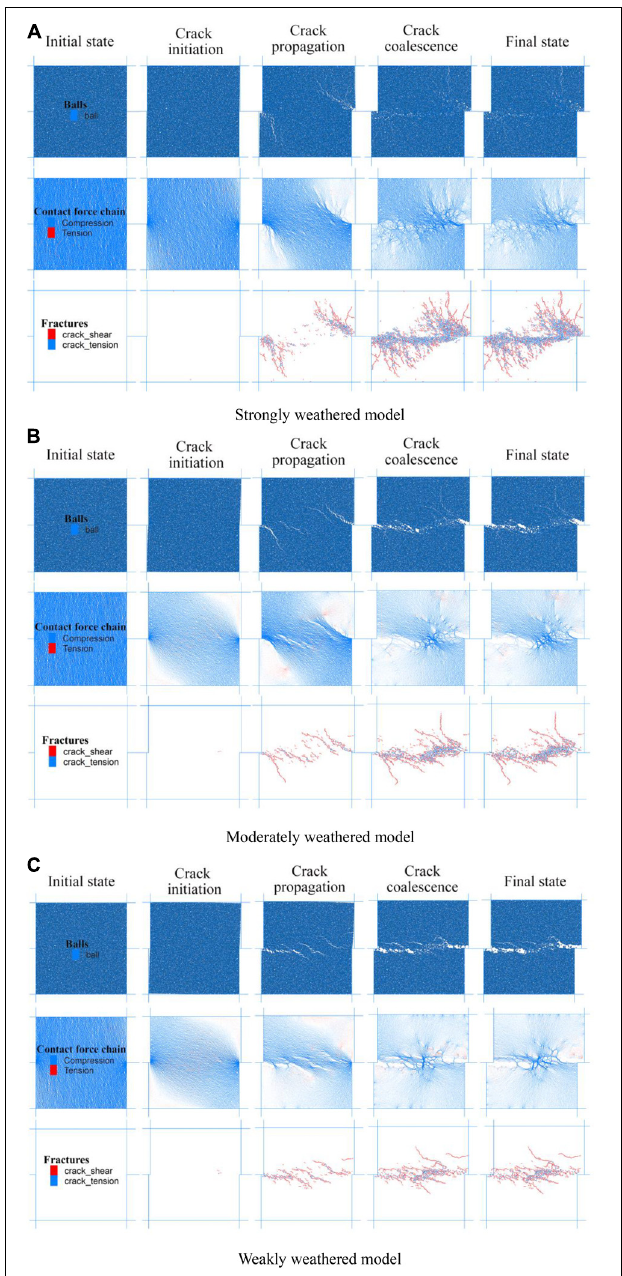
FIGURE 7 | Failure stages of models with different degrees of weathering. (A) Strongly weathered model. (B) Moderately weathered model. (C) Weakly weathered